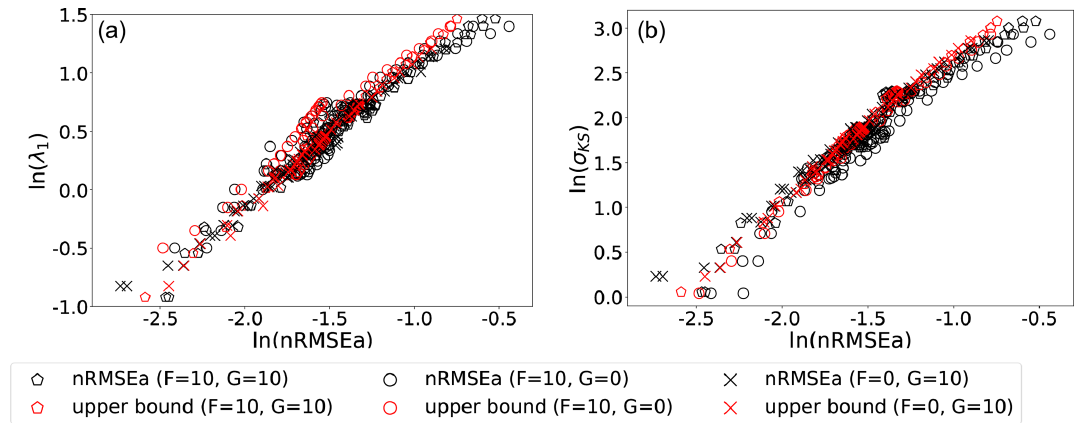
Figure 8. Scatter of σ KS (a) and λ 1 (b) against nRMSEa for experiments where either the momentum or the thermodynamic variable alone is observed. The log–log scale is used on both axes, and points represent experiments with the same model parameter values used in Figs. 3 and 5, excluding weakly unstable cases with σ KS < 1 and hence excluding cases where ln ( nRMSEa ) < − 4, similar to Fig. 7.